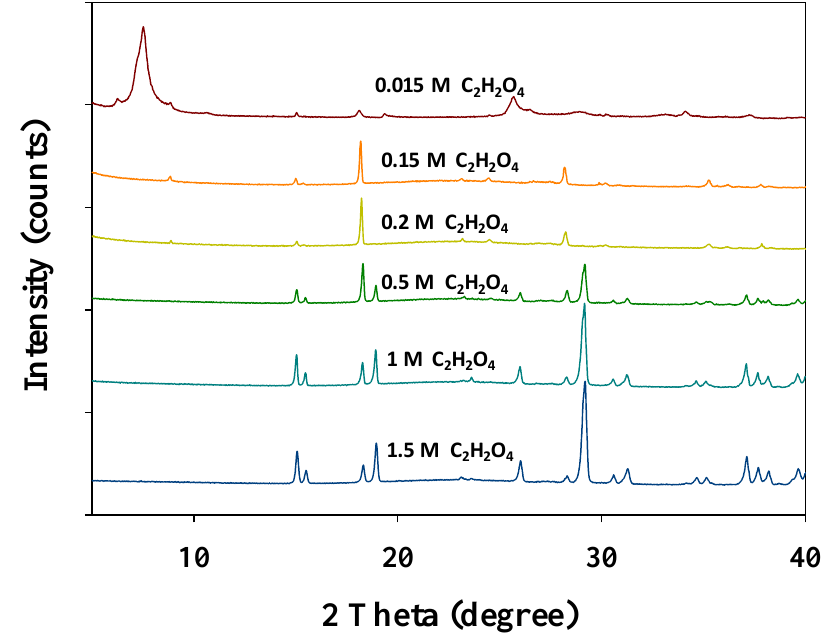
Figure 4. X-ray diffraction (XRD) patterns of 133 Cs–HBT treated with various concentrations of oxalic acid. The solid/liquid samples were separated using a centrifuge following desorption treatment, and the dried solid particles were analyzed using XRD.